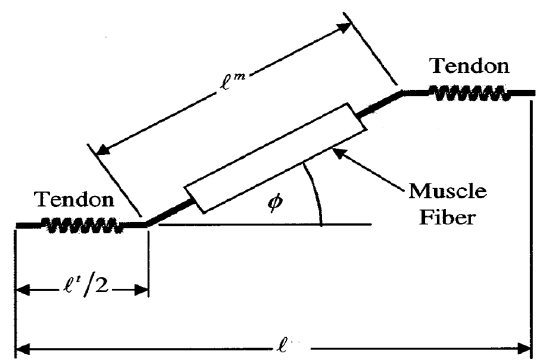
Figure 2. A diagram of muscle-tendon unit that shows the relationship of muscle-tendon length, muscle fiber length, tendon length, pennation angle. Where l is the muscle-tendon length, l m is the muscle fiber length, l t is the tendon length, φ is the pennation angle.